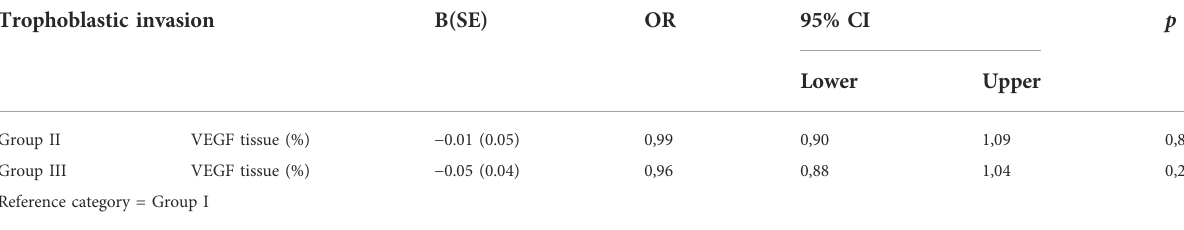
TABLE 2 VEG tissue expression associated trophoplastic invasion, as determinated by univariate multinomial regression analysis. Trophoblastic